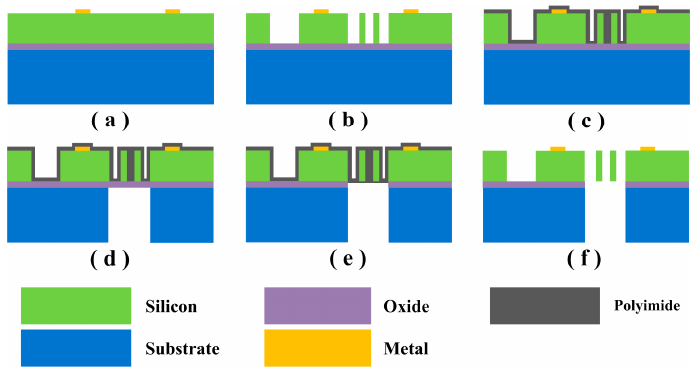
Figure 4. Main steps of the SOI micromachining process.